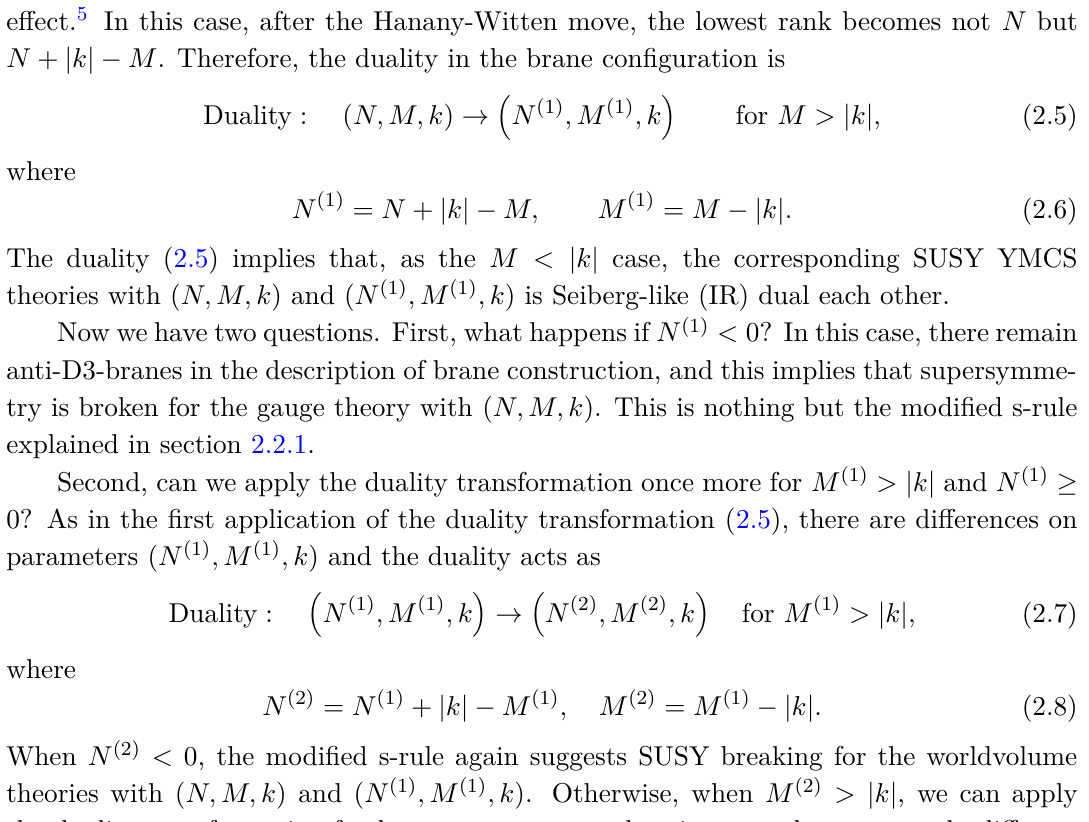
Figure 5 . The brane configuration after applying the Hanany-Witten move to the brane configura- tion of figure 2, which corresponds to the N = 3 U( N ) M = 1 , k = 3 in this figure). This implies the duality with the N = 3 U( N + | k |− M ) k × U( N ) − k the-